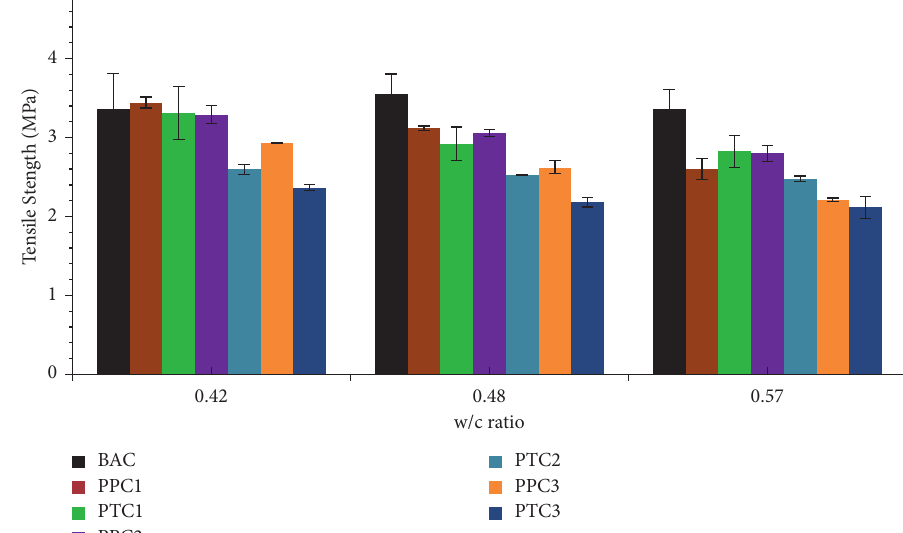
Figure 7: Variation in tensile strength of concrete with w/c ratio.